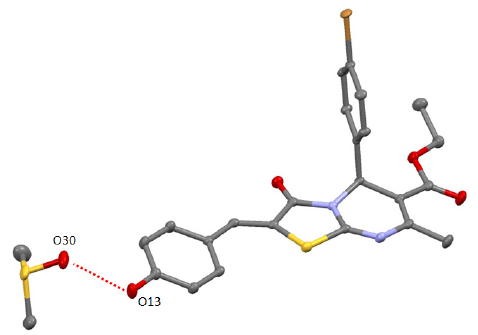
Figure 9. Crystal structure of solvate complex 14 ‐ DMSO .